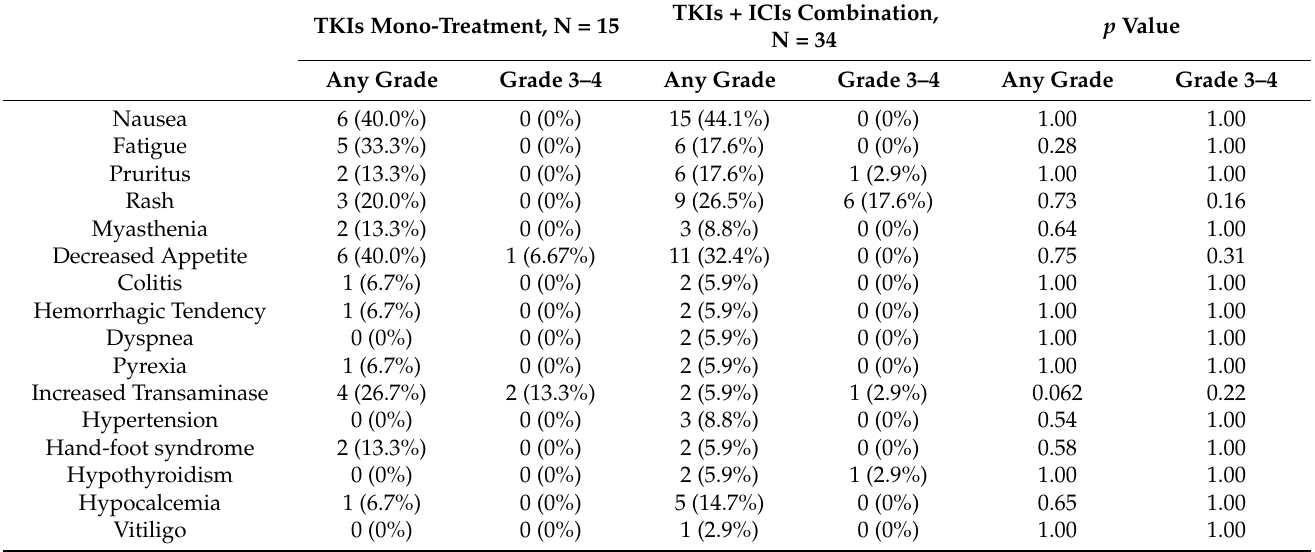
Table 3. Systemic therapy-related adverse events, N = 49 (%).